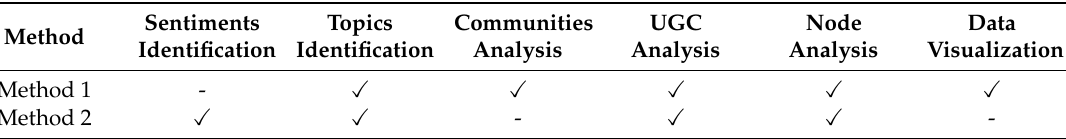
Table 4. Main characteristics of Methods 1 and